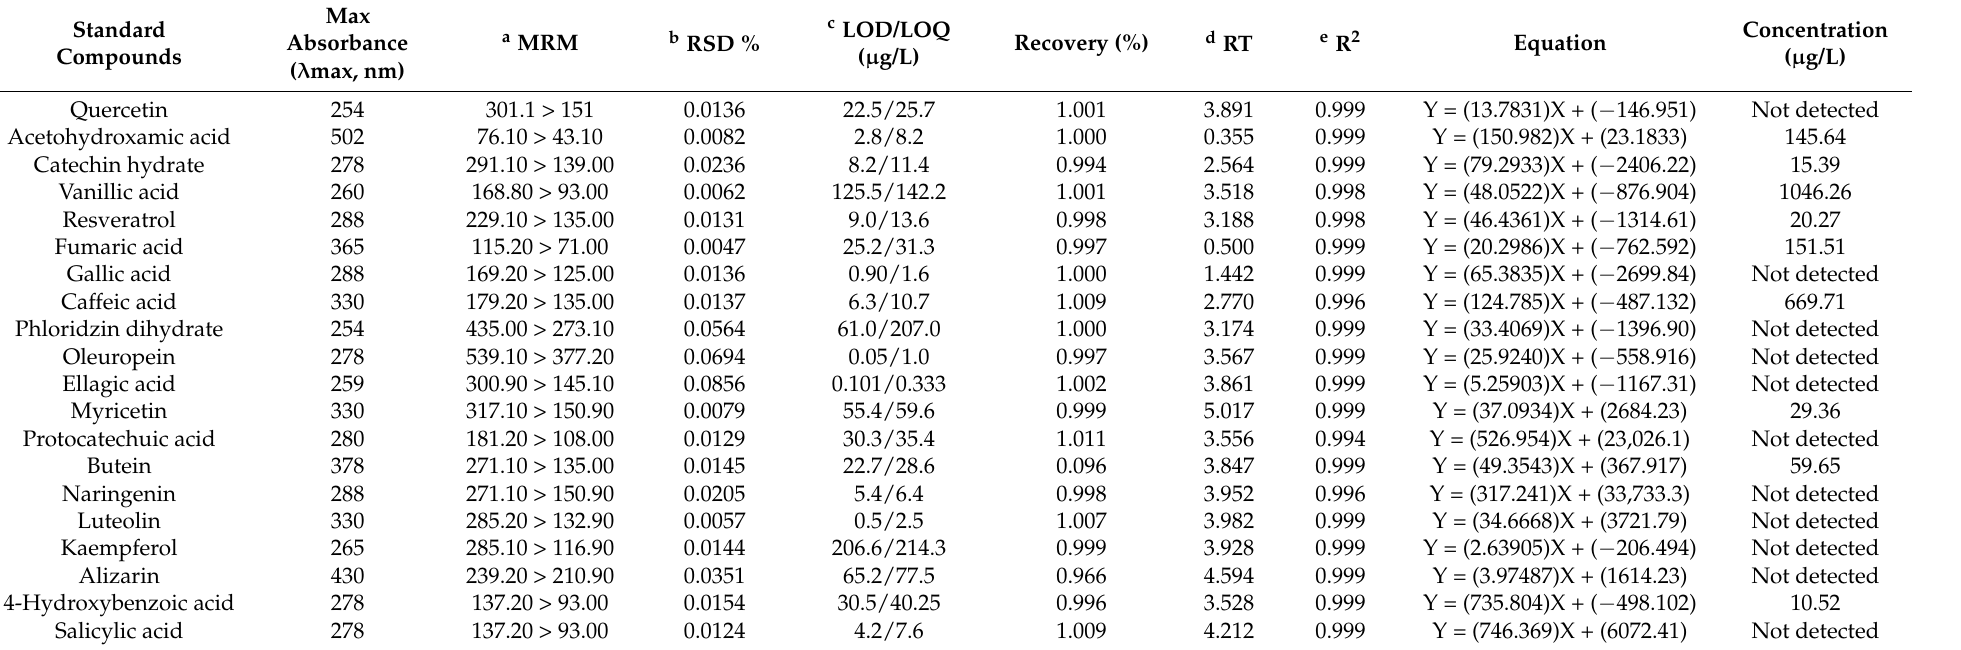
Table 1. The determination of phytochemical profiles of